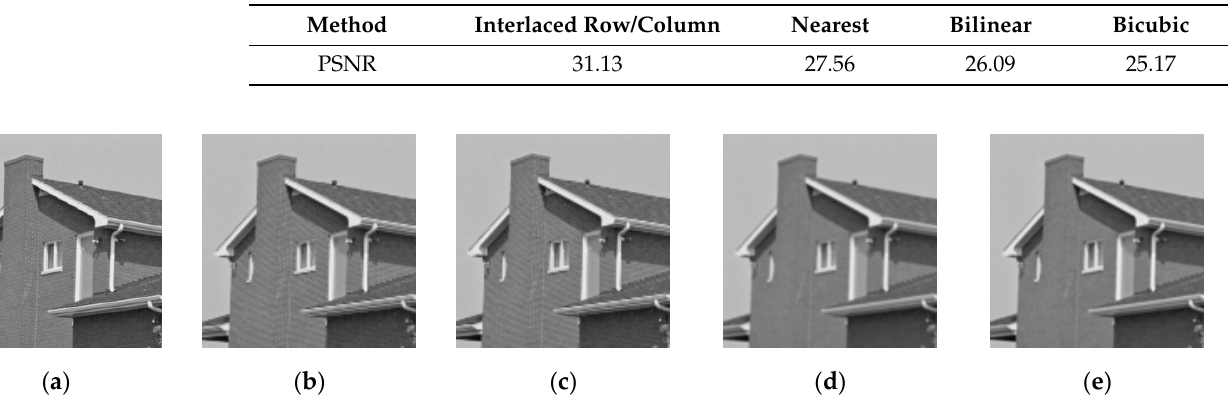
Table 1. A comparison of different downsampling methods with respect to the PSNR (dB).